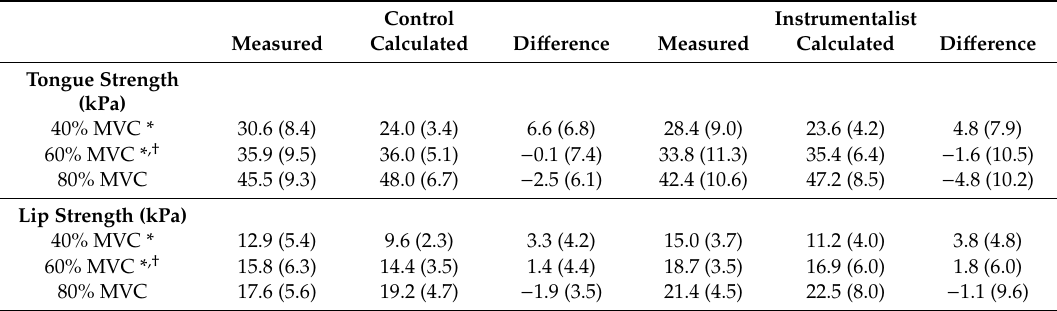
Table 1. Tongue and lip estimated intensities. † p < 0.05 compared to the 40% di ff erences for condition main e ff ect. * p < 0.05 compared to the 80% di ff erences for condition main e ff ect.